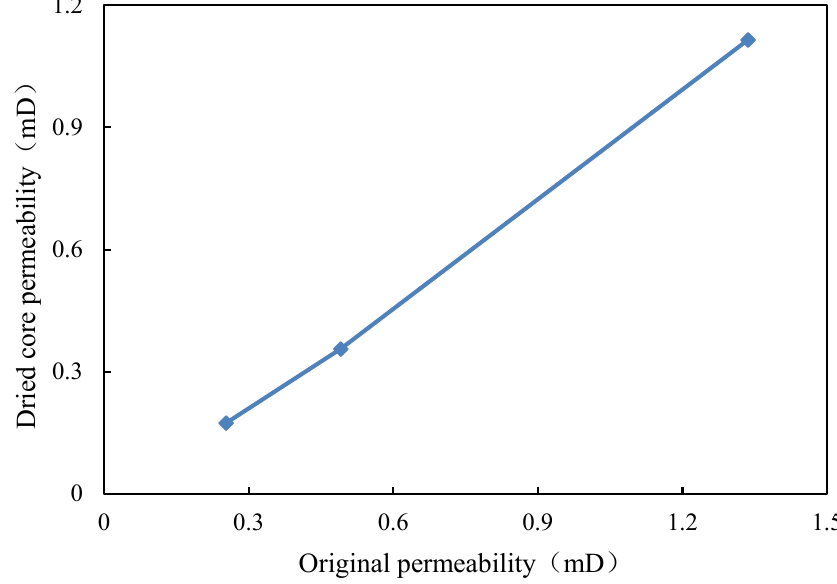
Figure 5. Relationship between dry core permeability and original permeability.